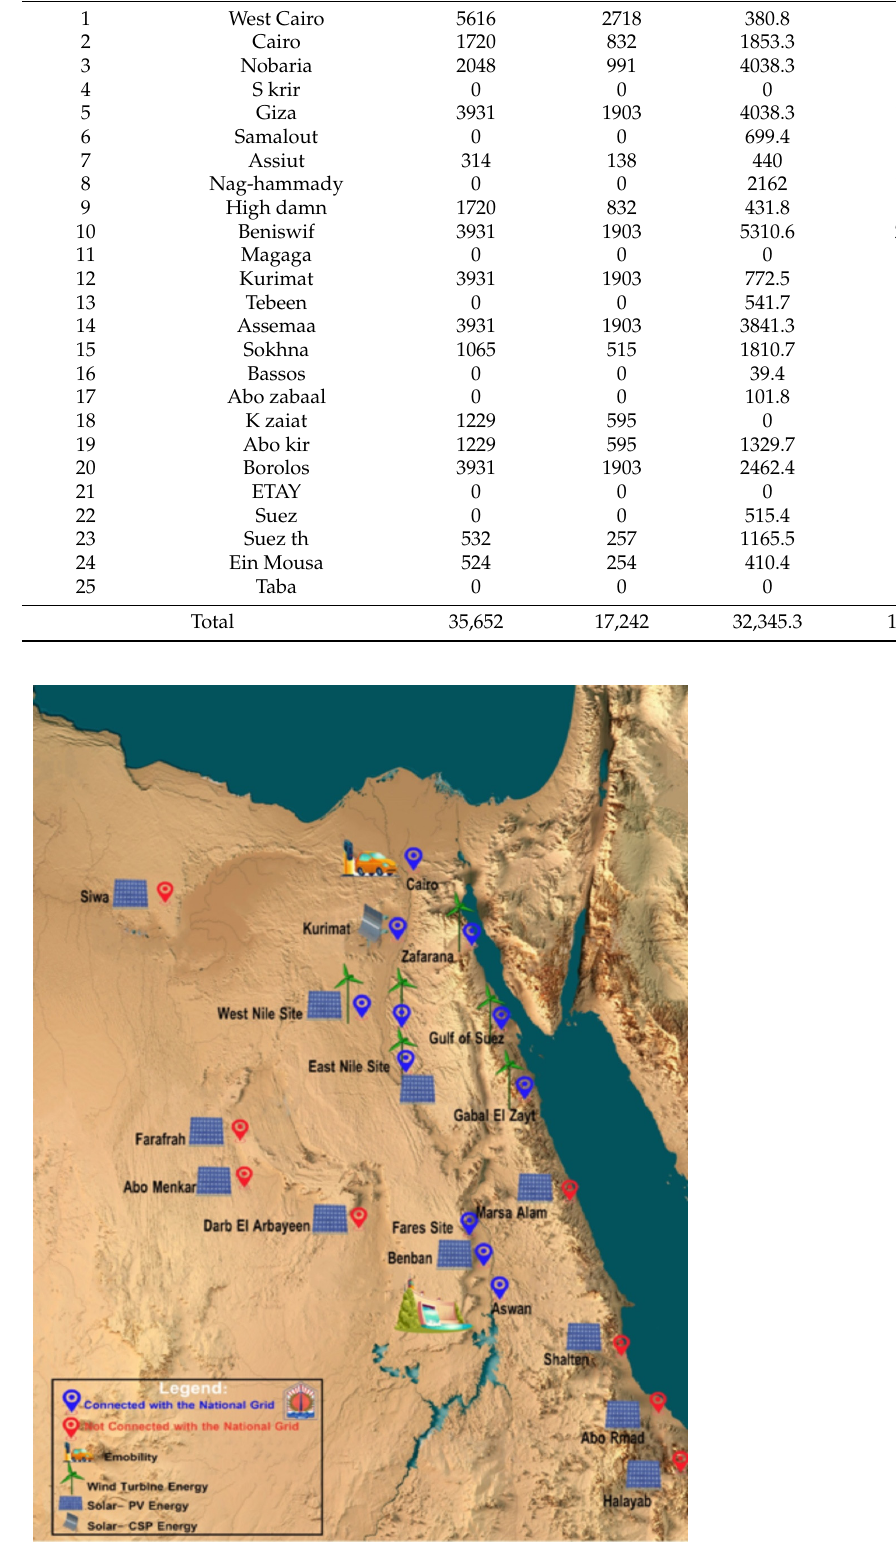
Figure 10. The plan of installed, under construction & under-development solar and wind pro-